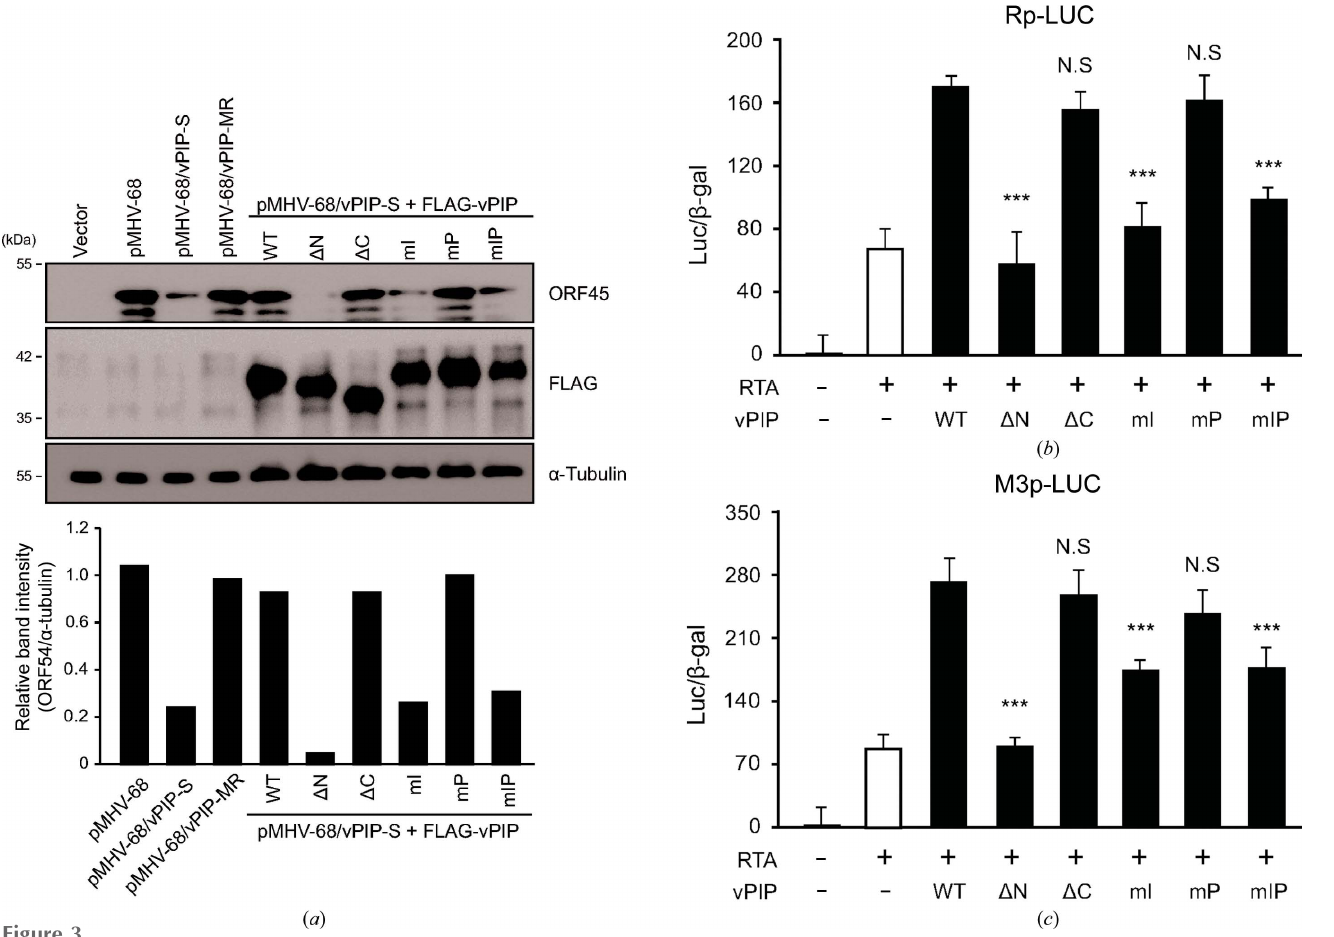
Figure 3 Effects of vPIP mutations on the regulation of virus lytic replication. ( a ) Trans-complementation of vPIP-S virus replication by vPIP mutants. Vero cells were co-transfected with FLAG-tagged vPIP mutants in the presence of the vPIP-S virus BAC DNA (pMHV-68/vPIP-S). MHV-68 BAC DNA (pMHV- 68) and vPIP-S-MR were used as a control. After 5 d of transfection, the cell lysates were subjected to Western blotting. The band intensity of the ORF45 protein was measured and normalized with that of (cid:2) -tubulin using the ImageJ program. ( b , c ) The effect of vPIP mutants on RTA-mediated transactivation. HEK293T cells were transfected with the reporter construct containing RTA promoter (Rp-LUC) ( b ) or M3 promoter (M3p-LUC) ( c ), and vPIP mutants in the presence of RTA-expressing plasmid. Each transfection was performed in triplicate, with a (cid:3) -galactosidase-expressing plasmid included as an internal control. Statistical analysis was performed using a two-sided Student’s t-test (*** denotes a P value of <0.005 against WT vPIP expressing